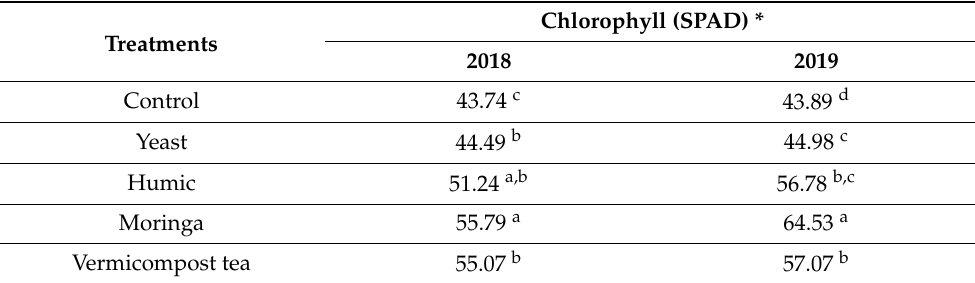
Table 9. Effect of different biostimulant extracts on total chlorophyll in growing seasons of 2018 and